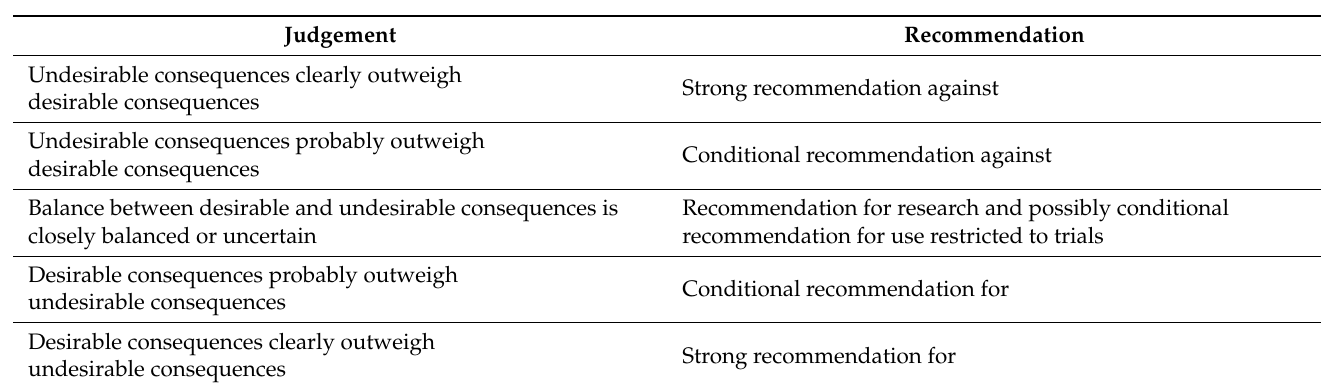
Table 4. Forms of recommendation